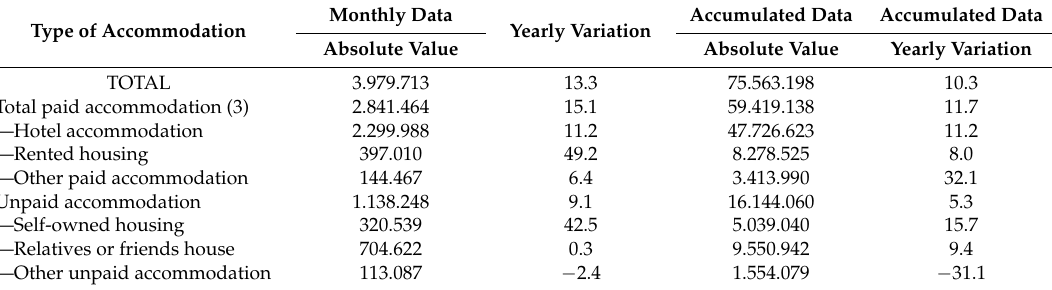
Table 2. International tourists depending on type of accommodation.